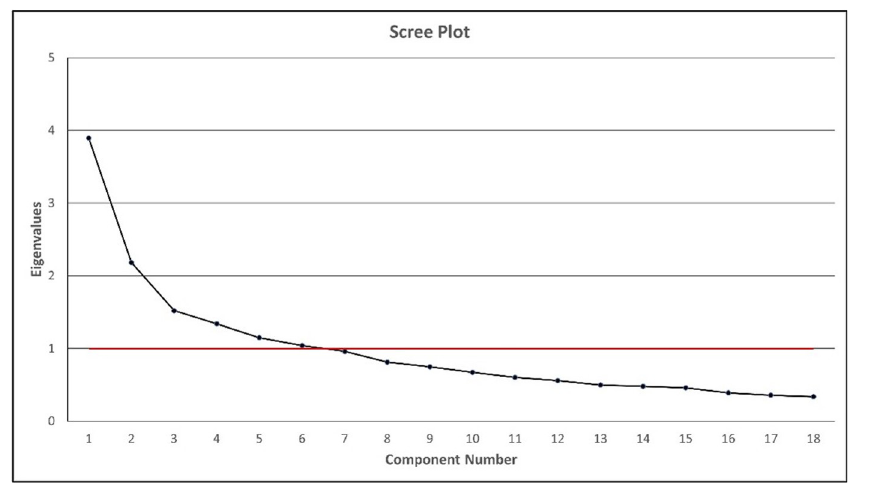
Fig 3. Number of components.